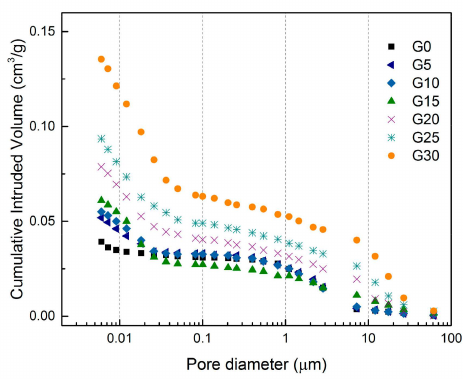
Figure14. Di ff erencesintheporedistributionofselectedmixturesofAASmortarswithgraphitepowder.